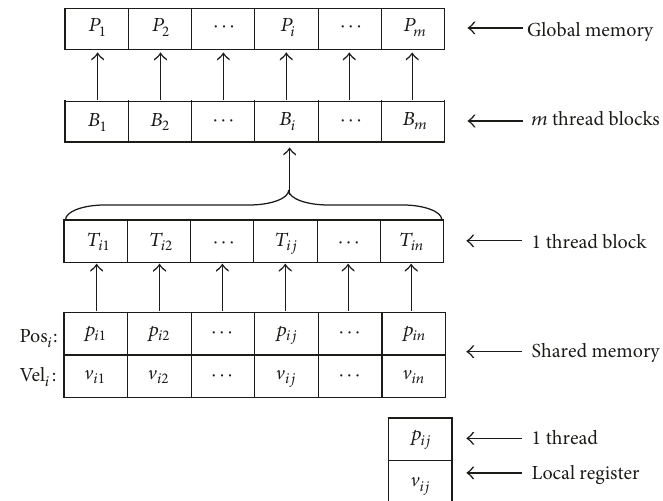
Figure 1: Data structure and parallel pattern of